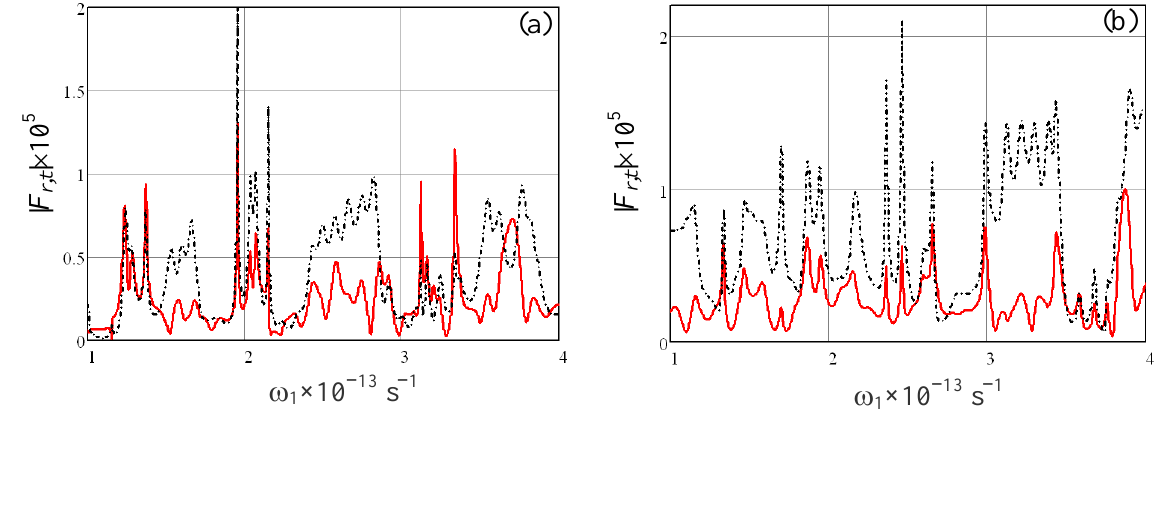
Figure 4. Intensity of field radiated from QPSs at frequency ω (| F |-solid red lines) and forward (| F r ( a ) Fibonacci S stack at ω = 2.02 × 10 13 s −1 ; ( b ) Thue-Morse Q 7 2